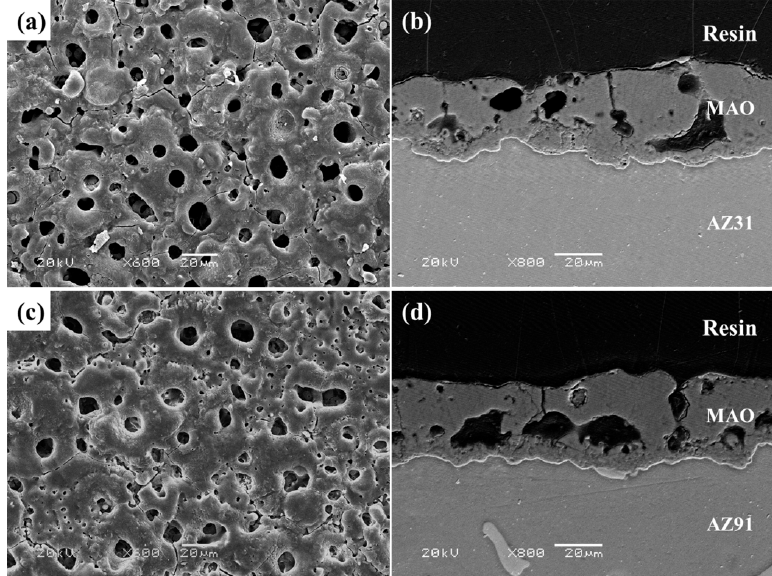
Figure 2. Surface and cross-section SEM micrographs of MAO coatings on ( a , b ) AZ31 and ( c , d ) AZ91 Mg alloys.